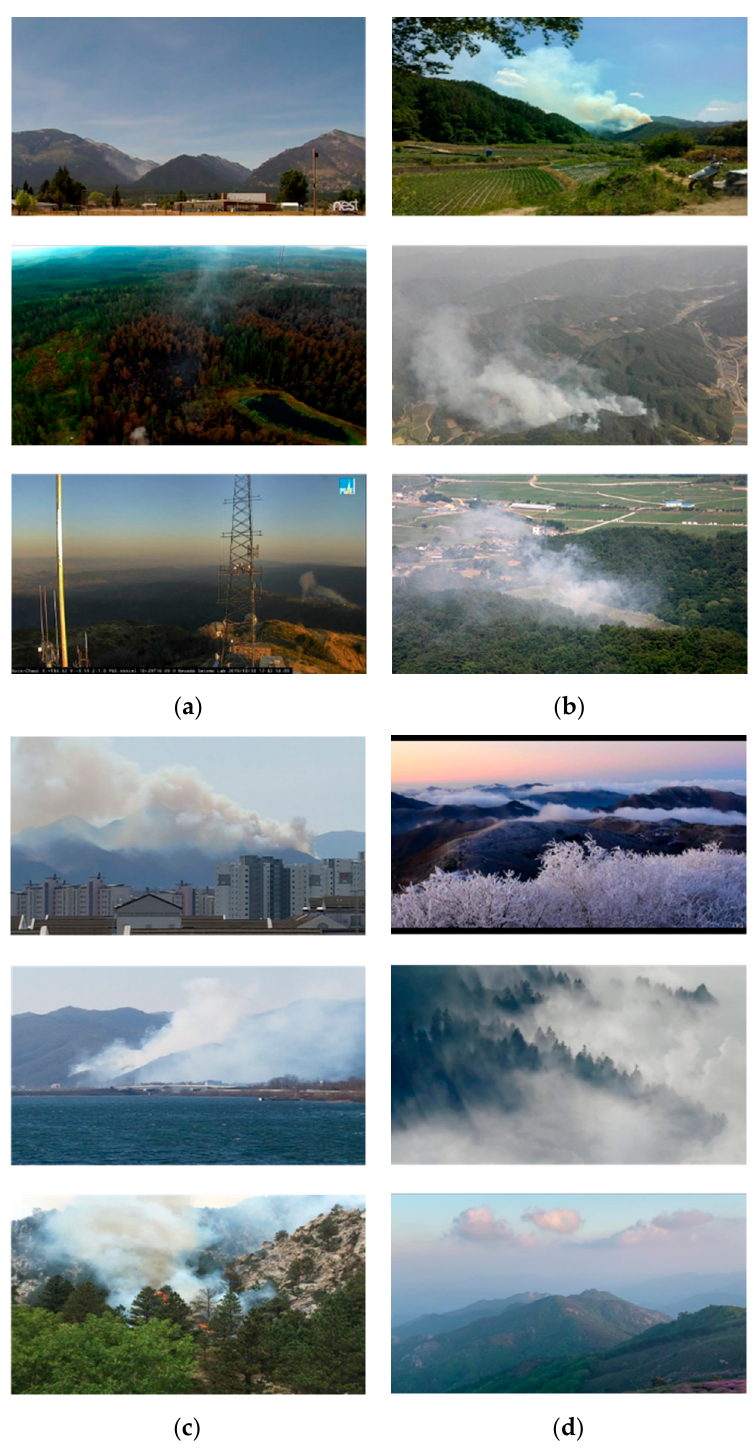
Figure 7. Samples of various benchmark wildfire smoke and smoke-like sequences used in training and testing: ( a ) Small-, ( b ) medium-, and ( c ) large-sized wildfires, and ( d ) cloud and